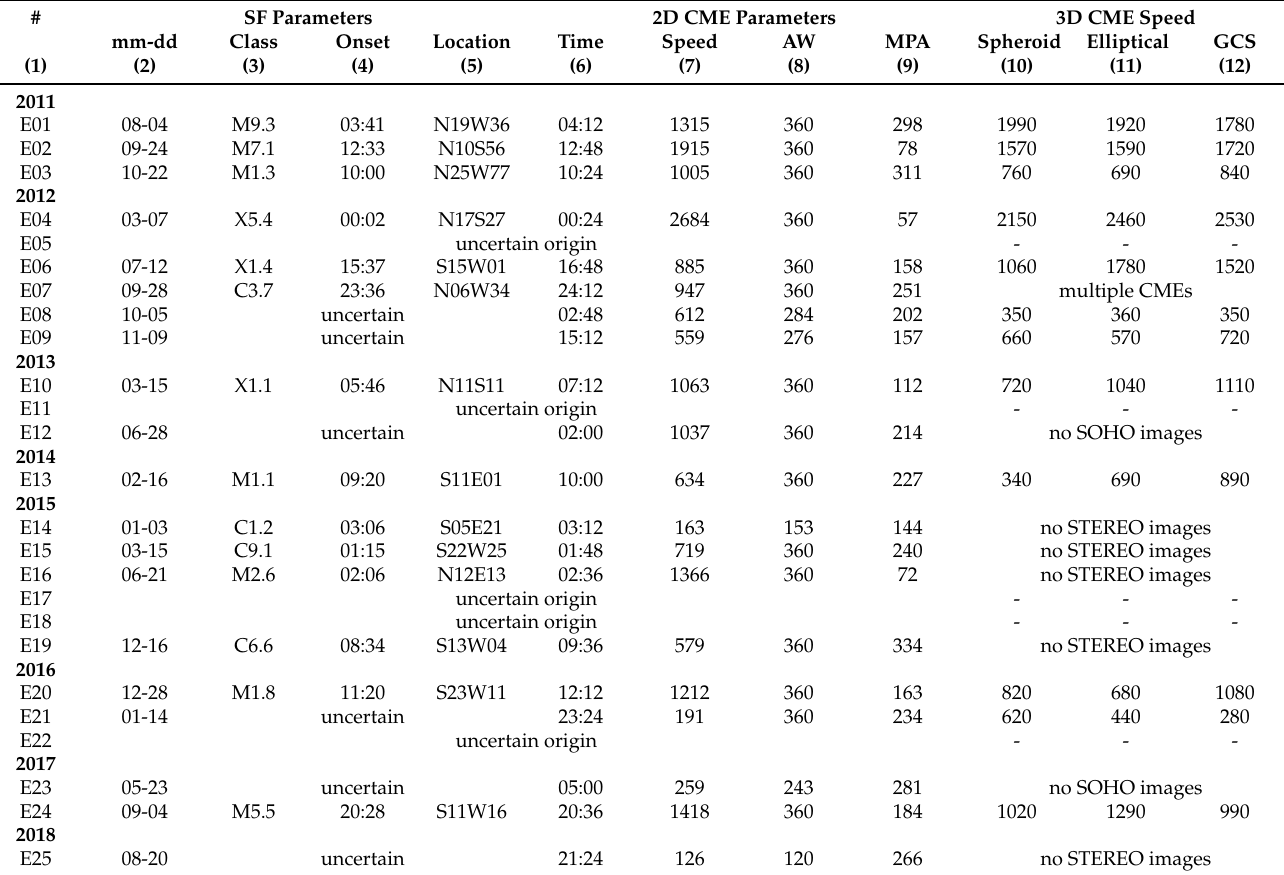
Table 2. Parameters of the solar origin, SFs and CMEs, of the GSs from Table 1. All times are in UT, speeds in kms − 1 , AW and MPA in degrees. The event labels (in col. 1) are as in Table